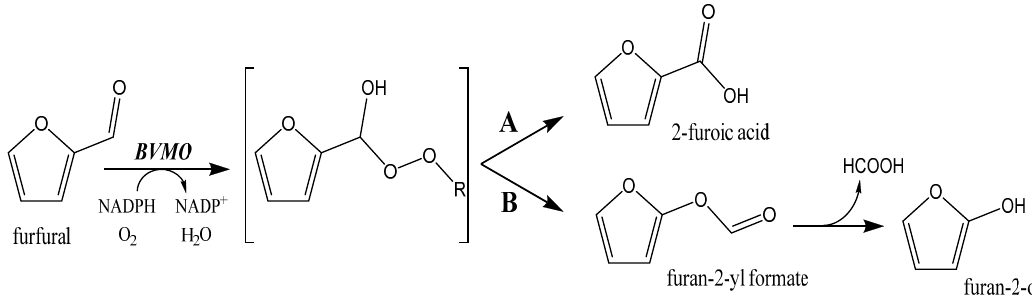
Figure 1. Example of the biocatalytic oxidation of furfural by the action of a Baeyer-Villiger monooxygenase (BVMO). The reactive peroxyflavin enzyme intermediate of a BVMO will form a Criegee intermediate leading to 2-furoic acid (route A ) or to the typical Baeyer-Villiger oxidation product, the formyl ester (route B ). The formyl ester undergoes hydrolysis in an aqueous solution.